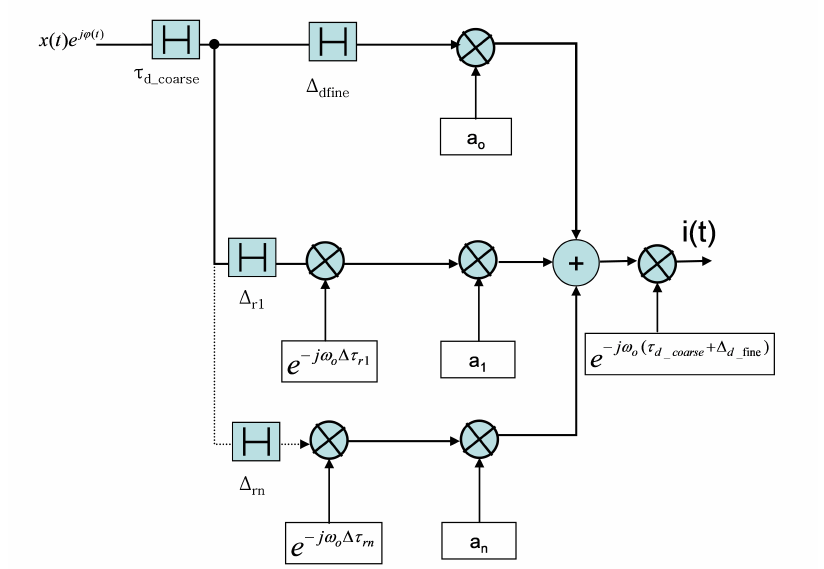
Figure 3. Representation of the multipath signal in the complex envelope domain with delays and time-discrete